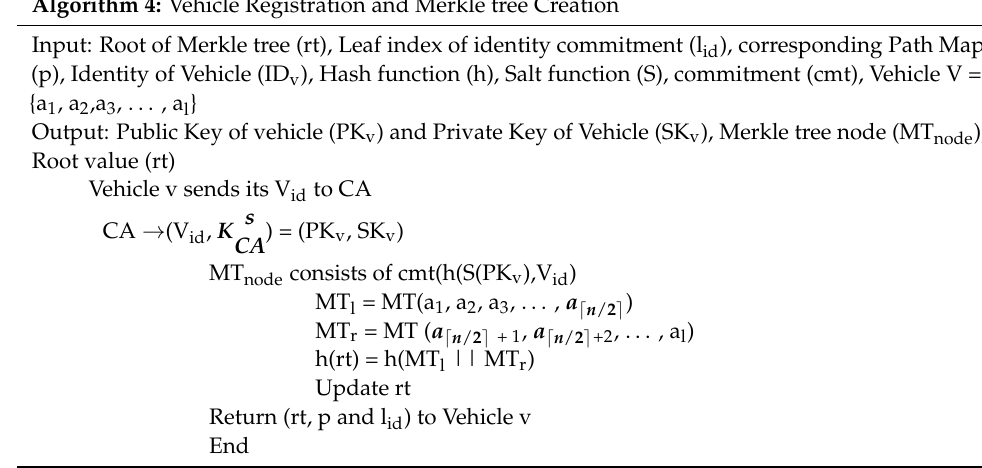
Algorithm 4: Vehicle Registration and Merkle tree